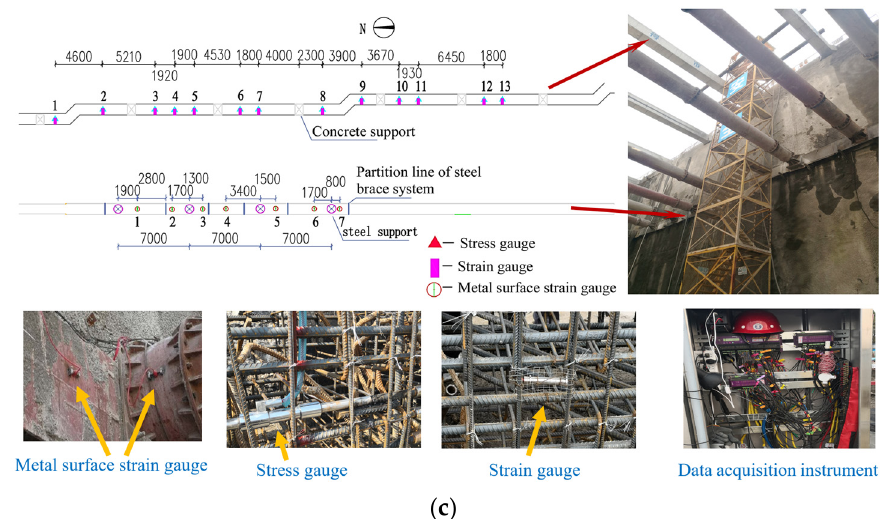
Figure 17. Monitoring point of foundation pit. ( a ) monitoring point for inclination (unit: mm, scale: 1:200); ( b ) monitoring points for stress and strain meters of retaining piles (unit: mm, scale: 1:50); ( c ) monitoring points for stress and strain meters of support beam (unit: mm, scale: 1:200).